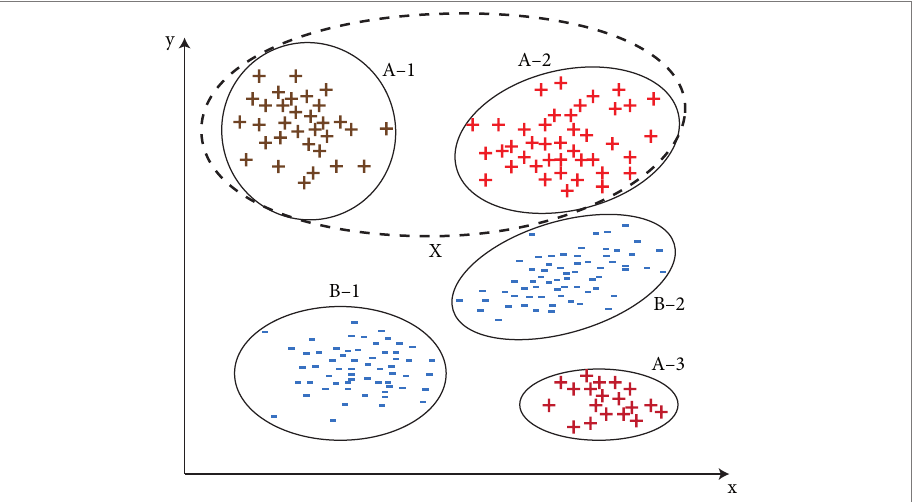
Fig. 2. In the case of a complex class structure combinations of clusters should be considered because a change in class structure changes the classification